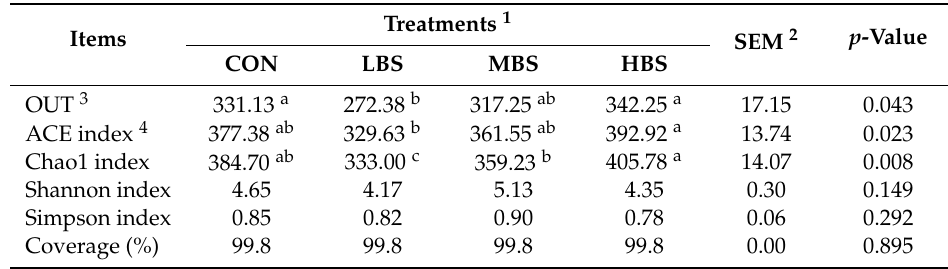
Table 4. Number of observed species, richness and diversity indices in ruminal samples from each dietary treatment.